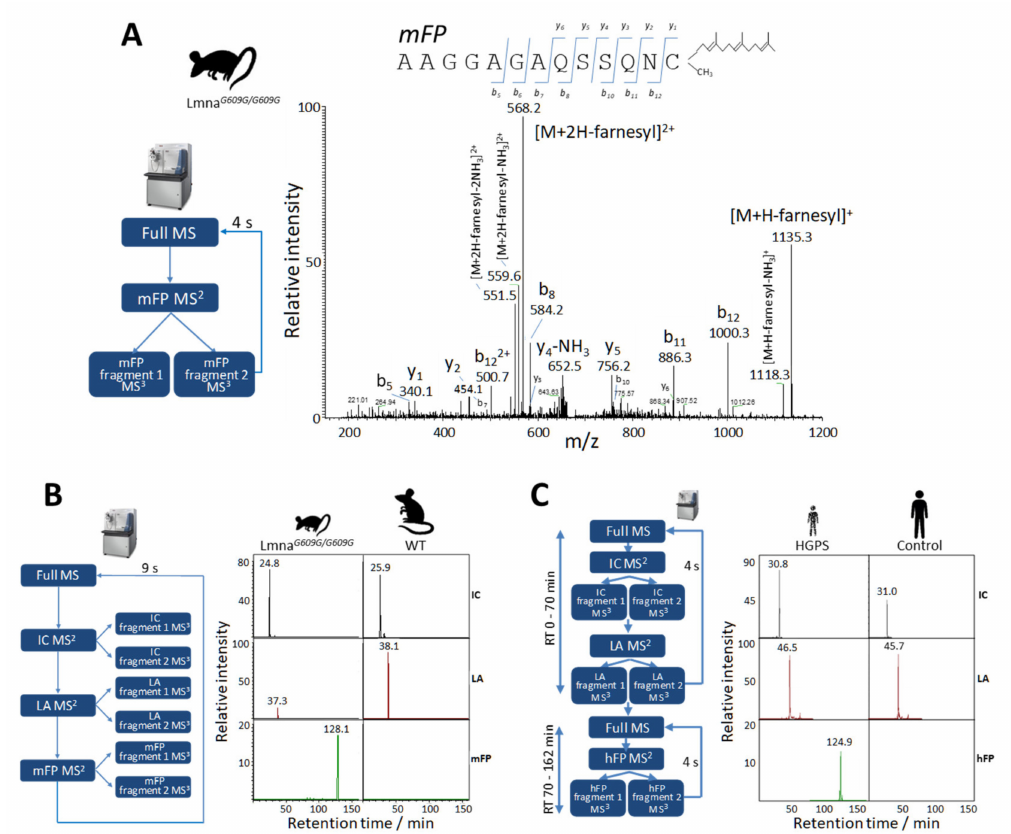
Figure 5. Relative quantification of progerin by parallel reaction monitoring (PRM) analysis in mouse and human samples. ( A ) MS 2 fragmentation spectrum of the endogenous mFP farnesylated peptide obtained by PRM analysis of skin fibroblast nuclei from progeroid Lmna 609G/G609G mice. The chart shows ion ascription to the main fragment-ion series (C-terminal y-series and N-terminal b-series). ( B ) Representative MS 3 extracted ion chromatograms (XICs) of IC , LA , and mFP peptides obtained from the PRM assay with Lmna G609G/G609G and wild-type mouse skin fibroblasts for the relative quantification of lamin A and progerin (see Table 1 for details). Relative intensities were normalized to that of IC , which was assigned an arbitrary intensity of 100 in the Lmna 609G/G609G sample. ( C ) Representative MS 3 XICs of IC , LA and hFP peptides obtained by time-scheduled PRM assay with human Hutchinson-Gilford progeria syndrome (HGPS) and control skin fibroblasts for the relative quantification of lamin A and progerin (see Table 2 for details). Relative intensities were normalized to that of endogenous peptide IC , which was assigned an arbitrary intensity of 100 in the HGPS